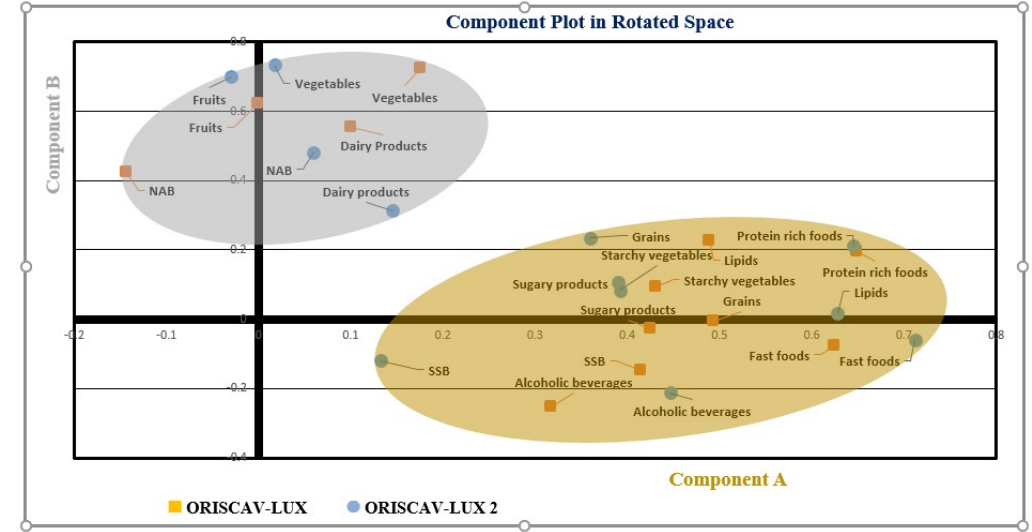
Figure 2. The exploratory factor analysis (EFA) was used to identify two major components, using the data from the FFQ organized into 12 major food groups. A component plot in rotated space for both ORISCAV-LUX and ORISCAV-LUX 2 is represented. Component A included fast foods (ready-to-eat meals), lipids, grains, starchy vegetables, alcoholic beverages, SSB (sugar-sweetened beverages), sugary products, and protein-rich foods. Component B included fruits, vegetables, NAB (nonalcoholic beverages), and dairy products.